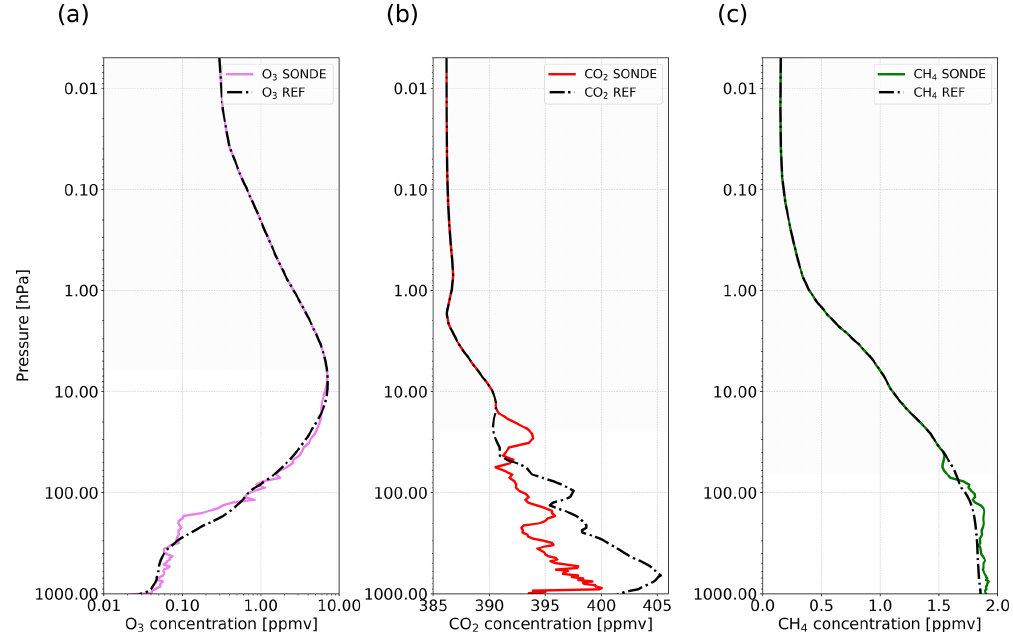
Figure 7. Representation of reference profiles (dash-dotted black lines) of O 3 (a) , CO 2 (b) and CH 4 (c) and profiles measured by in situ sounding and convoluted with reference profiles of O 3 in violet (a) , CO 2 in red (b) and CH 4 in green (c) .